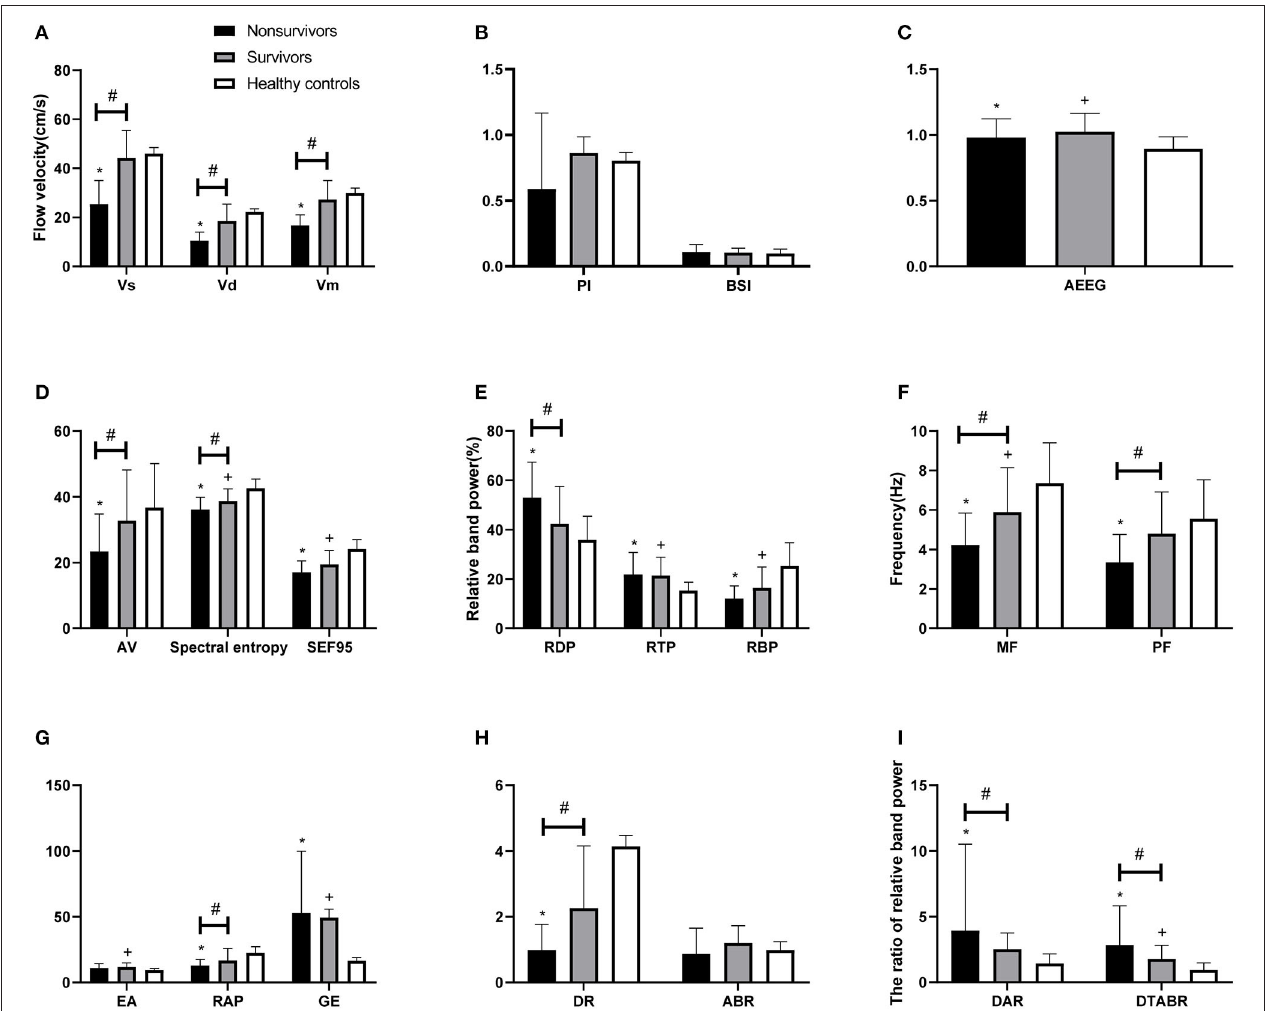
FIGURE 2 | Comparison of TCD and QEEG parameters between patients with PCCI and healthy controls. (A) Systolic flow velocity (VS), diastolic flow velocity (VD), mean flow velocity (VM); (B) pulsatility index (PI), brain symmetry index (BSI); (C) amplitude-integrated EEG (AEEG); (D) alpha variability (AV), spectral entropy, 95% spectral edge frequency (SEF95); (E) relative band power of delta, theta, beta; (F) median frequency (MF), peak frequency (PF); (G) envelope analysis (EA), relative band power of alpha, gross energy (GE); (H) delta ratio (DR), alpha/beta ratio (ABR); (I) delta/alpha ratio (DAR), (delta + theta)/(alpha + beta) ratio (DTABR). # P < 0.05 for non-survivors vs. survivors; * P < 0.05 for non-survivors vs. healthy controls; + P < 0.05 for survivors vs. healthy